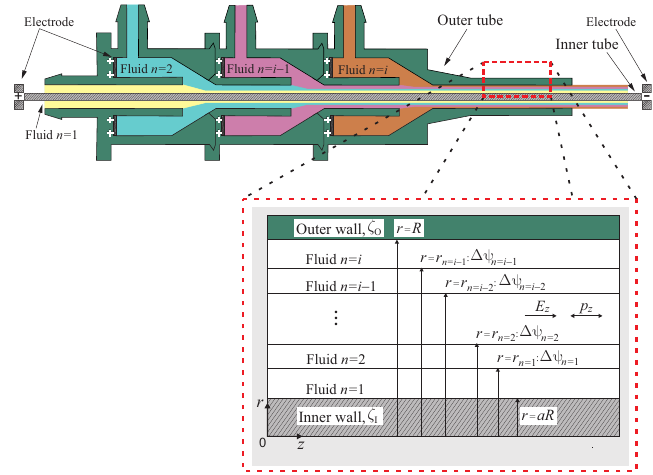
Figure 1. Sketch of the microfluidic device to generate aligned concentric flow. The red square shows the arrangement of the electro-osmotic flow of multilayer immiscible fluids in the studied